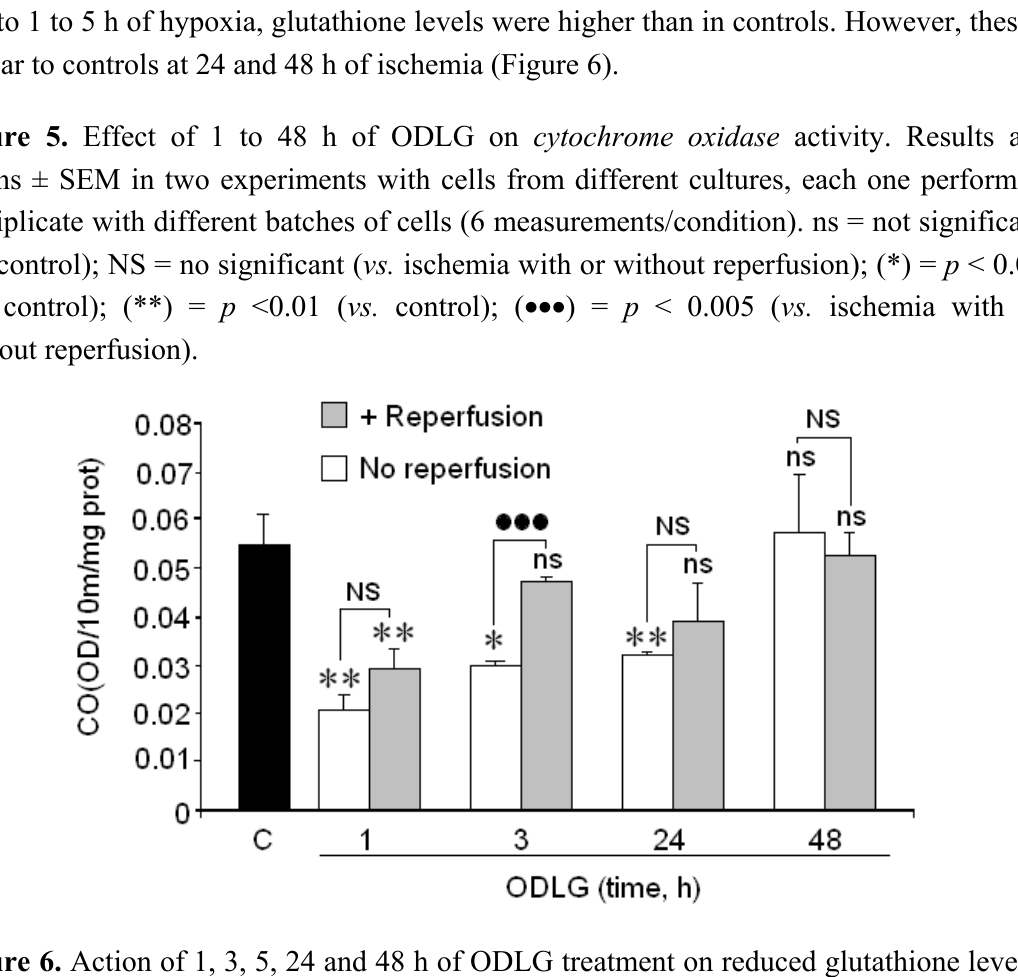
Figure 6. Action of 1, 3, 5, 24 and 48 h of ODLG treatment on reduced glutathione levels, before and after 24 h of reperfusion. Results are means ± SEM of two experiments with cells from different cultures, each one performed in triplicate (6 measurements/condition). ns = no significant ( vs . control); NS = no significant ( vs . ischemia with or